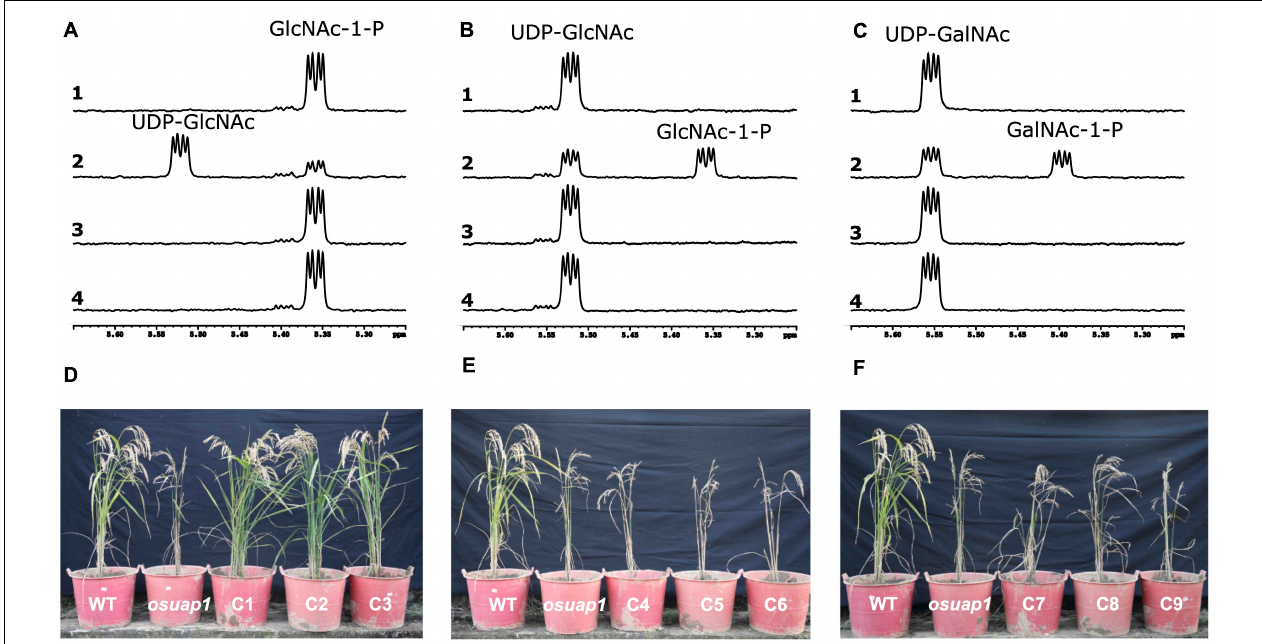
FIGURE 8 | In vitro and in vivo activity of isoforms from OsUAP1. Enzymatic activities of three isoforms of OsUAP1 based on 1 H-nuclear magnetic resonance ( 1 H-NMR). (A) Forward activity: UTP + GlcNAc-1-P → UDP-GlcNAc + PPi. (B) Reverse activity: UDP-GlcNAc + PPi → GlcNAc-1-P + UTP. (C) Reverse activity: UDP-GalNAc + PPi → GalNAc-1-P + UTP. (A–C) Line 1, glutathione S-transferase (GST) control. Line 2, the protein of OsUAP1.1. Line 3, the protein of OsUAP1.2. Line 4, the protein of OsUAP1.3. (D) The phenotype of wild-type (WT), mutant (osuap1), and three independent complementary transgenic lines overexpressing OsUAP1.1. (E) The phenotype of WT, mutant (osuap1), and three independent complementary transgenic lines overexpressing OsUAP1.2. (F) The phenotype of WT, mutant (osuap1), and three independent complementary transgenic lines overexpressing